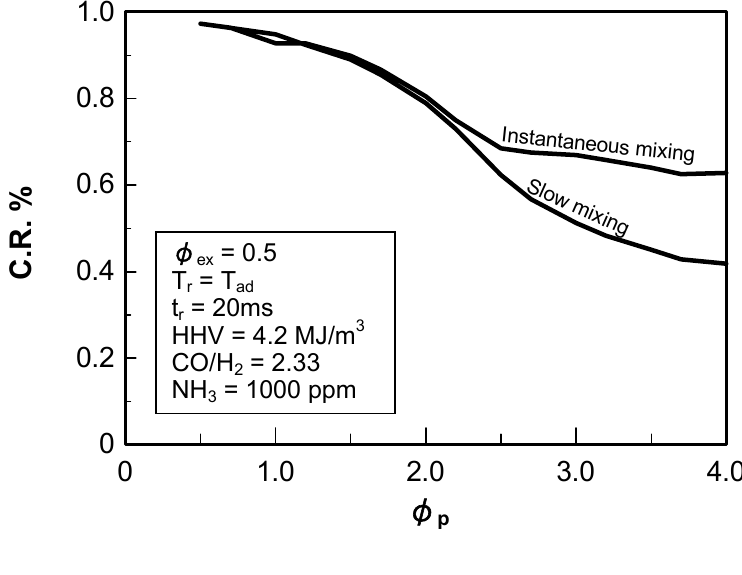
Figure 51. Effect of secondary-air introduction methods on conversion rate of NH to NOx, defined by